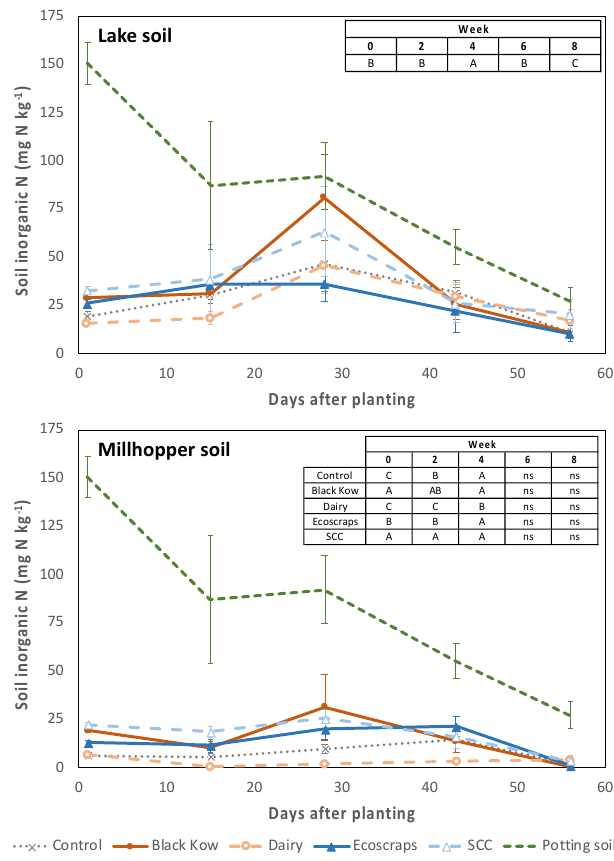
Figure 1. Mean ( ± standard errors) soil inorganic N (N-NH 4+ + N-NO 3 − ) in the Lake ( top ) and Millhopper ( bottom ) soil. Different letters in the in-chart table represent statistically different means for each week based on Tukey’s HSD ( α ≤ 0.05), where ns = not significant. There was a significant time x treatment interaction for the Millhopper soil whereas only time (and not treatment) had a significant effect in the Lake soil. The potting soil was not included in statistical